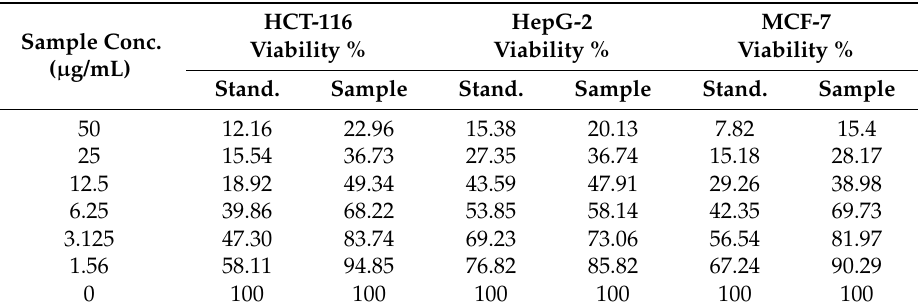
Table 5. Cytotoxicity of Au NPs in HCT-116, HepG-2, and MCF-7 cells, with IC 50 = 12.2, 10.3, and 11.2 µ g/mL,